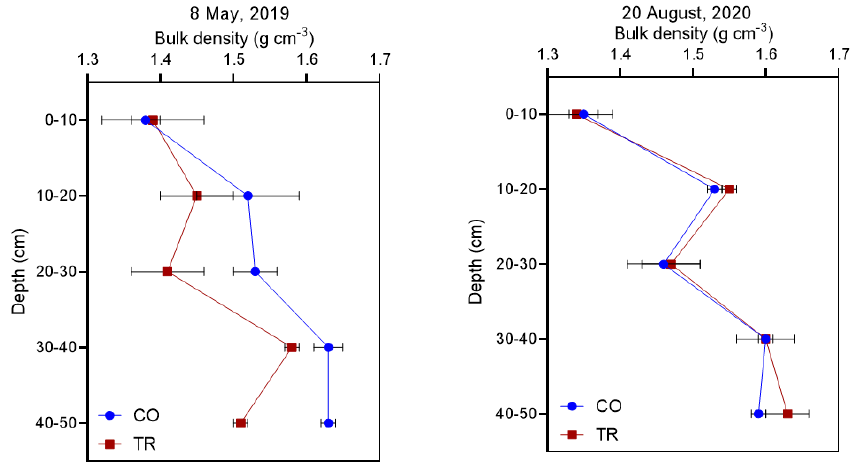
Figure 4. Soil bulk-density (g cm − 3 ) long the soil profile (0–50 cm) for the TR (with CC) and CO (without CC) systems before the CC killing (May 2019) and after the maize harvesting (August 2020). Horizontal bars represent the standard